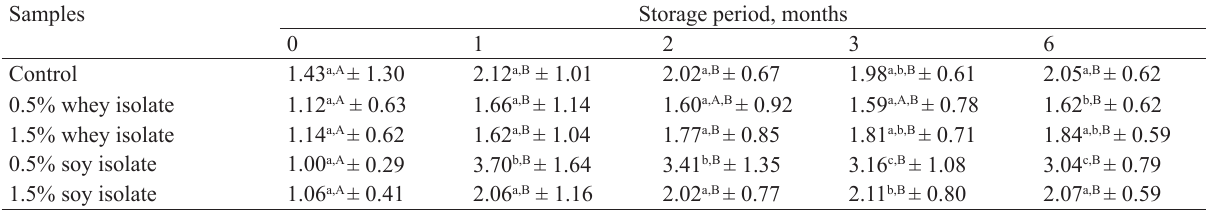
Table 3 Hardness of sausages with protein isolates (average value ± SD) Samples